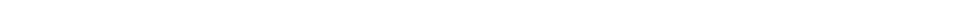
(see fi gure on previous page) Fig. 4 ATO stimulates ROS-dependent nuclear translocation of TFEB in macrophages. A , B RAW264.7 cells were treated with or without 2.5 μ M ATO for 60 min and 120 min. After immunostaining with TFEB (green) and DAPI (blue), cells were examined by fl uorescence microscopy. Scale bars = 10 μ m. The colocalization of TFEB and DAPI was calculated and analyzed (right panel) aaa p < 0.001 vs. Speci fi ed group. C , D WB analysis of subcellular distribution of TFEB in RAW264.7 cells between cytosol and nucleus after treated with 2.5 μ M ATO for indicated time (15, 30, 60, 90, 120 min). The data are quanti fi ed in the panel d. * p vs. TFEB relactive expression in nuclear of control group, # p vs. TFEB relactive expression in cytoplasm of control group. E , F Immuno fl uorescence analysis of the effects of 3-MA (2.5 mM, 2 h) and NAC (5 mM, 2 h) on TFEB nucleus translocation in RAW264.7 cells following ATO (2.5 μ M, 2 h) treatment. Scale bars = 10 μ m. G , H The effects of 3-MA (2.5 mM, 2 h) and NAC (5 mM, 2 h) on TFEB nucleus translocation in RAW264.7 cells following ATO (2.5 μ M, 2 h) treatment were detected by western blots. I Protein sequence alignment of TFEB homologs in different species. The asterisk indicates the evolutionarily conserved cysteine residue. J , K RAW264.7 cells were transfected with WT or mutant TFEB C211A. After 24 h, the cells were treated with ATO (2.5 μ M) for 15 min, which was pre-treated with or without NAC (5 mM) for 2 h. Then, the cell lysates were subjected to subcellular fractionation. The separated fractions were analyzed by immunoblotting with antibodies. * p vs. TFEB relative expression of Control group, # p vs. TFEB relative expression of ATO group, aaa p < 0.001 vs. Speci fi ed group. Data were expressed as mean ± SD from 3 independent experiments. *p < 0.05, ** p < 0.01, *** p < 0.001, and ns means non-signi fi